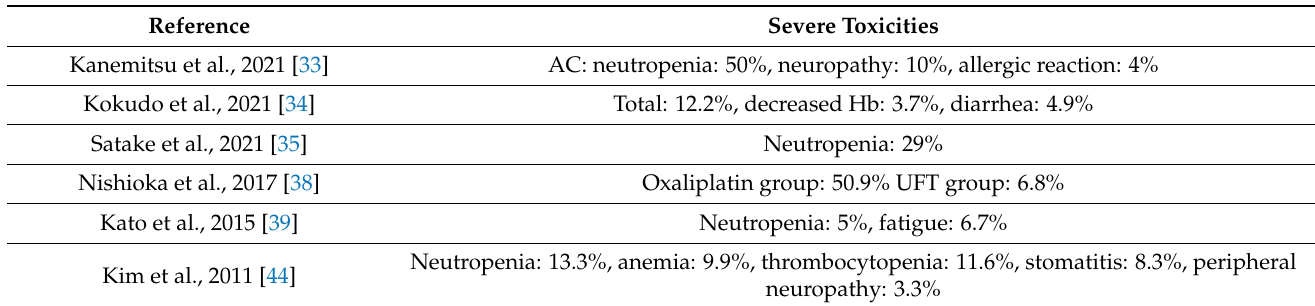
Table 5. Main severe toxicities in studies investigating adjuvant treatment after CRLM